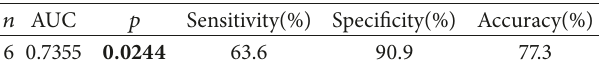
Table 2: Classification analysis results for PE in terms of highest AUC, including sensitivity (proportion of 10M+ correctly iden- tified), specificity (proportion of BL- correctly identified), and accuracy (proportion of total cases correctly classified), and their significance 𝑝 .